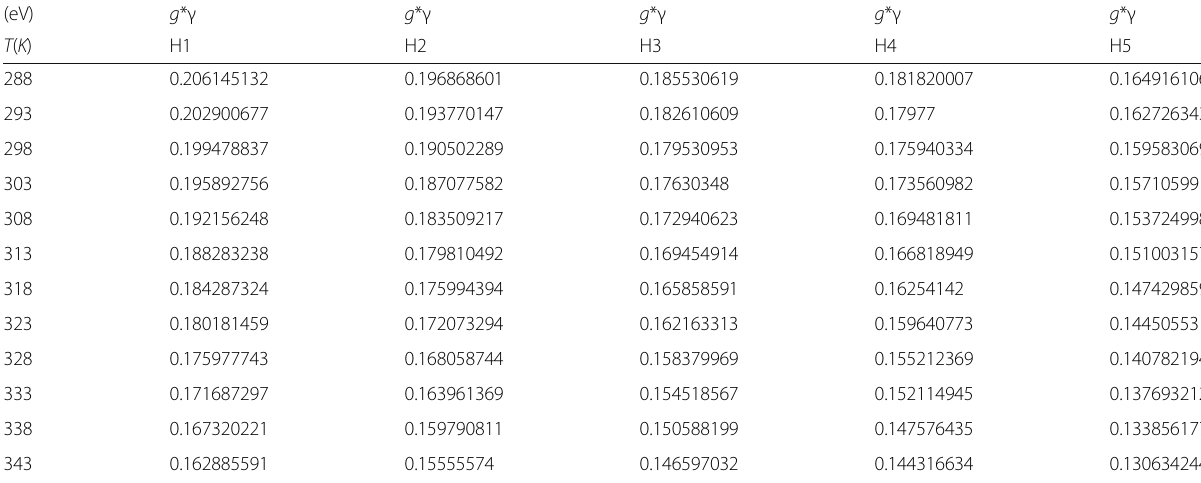
Table 4 Disorder energy of five energy levels corresponding to H1, H2, H3, H4, and H5; these times are used in fitting processes for AC-complex conductivity: electric conductivity and dielectric constant